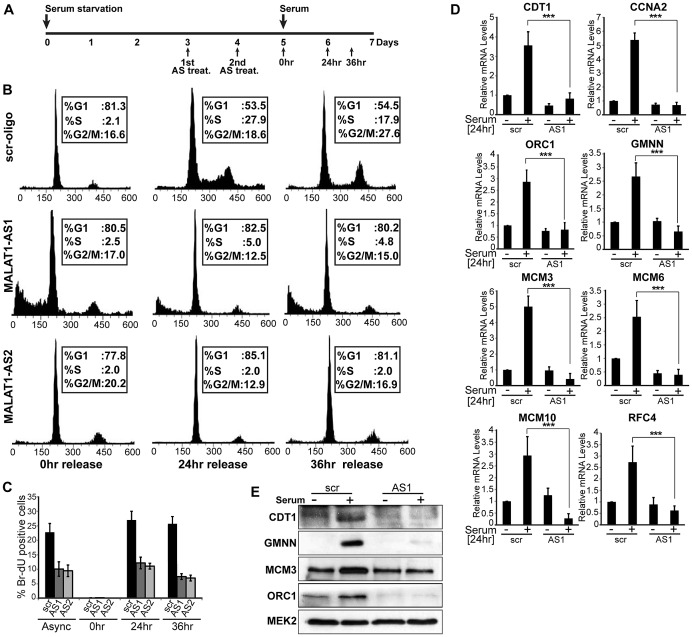
MALAT1-depleted HDFs show defects in G1 to S transition.(A) Flow chart depicting the experimental design. HDFs (WI-38 cells) are G0 arrested by serum starvation, followed by MALAT1depletion (AS treat.) and released from quiescence (G0) by the addition of serum and further examined for G1/S progression in presence or absence of MALAT1. (B–C) Flow cytometry analyses and BrdU-incorporation assays of control (scr-oligo) and MALAT1-depleted cells (AS1 & AS2). (D–E) Effect of MALAT1 knockdown on serum-induced growth control gene expression. Serum-starved WI-38 cells are depleted of MALAT1 followed by serum stimulation, and relative mRNA and protein levels of indicated genes are determined by qPCR and immunoblot analyses. Mean ± SEM,**p<0.01 and ***p<0.001.